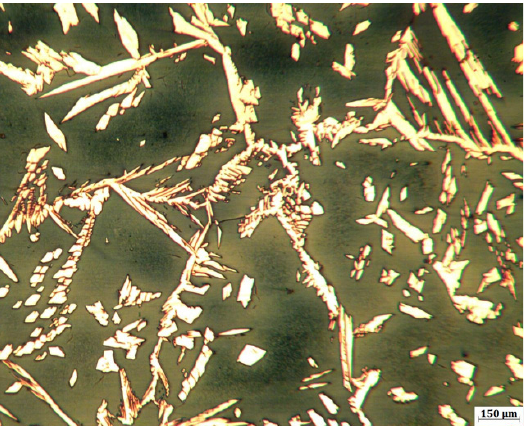
Figure 12. Microstructure from the 2205 DSS HTHAZ (1.6 kJ mm –1 ).